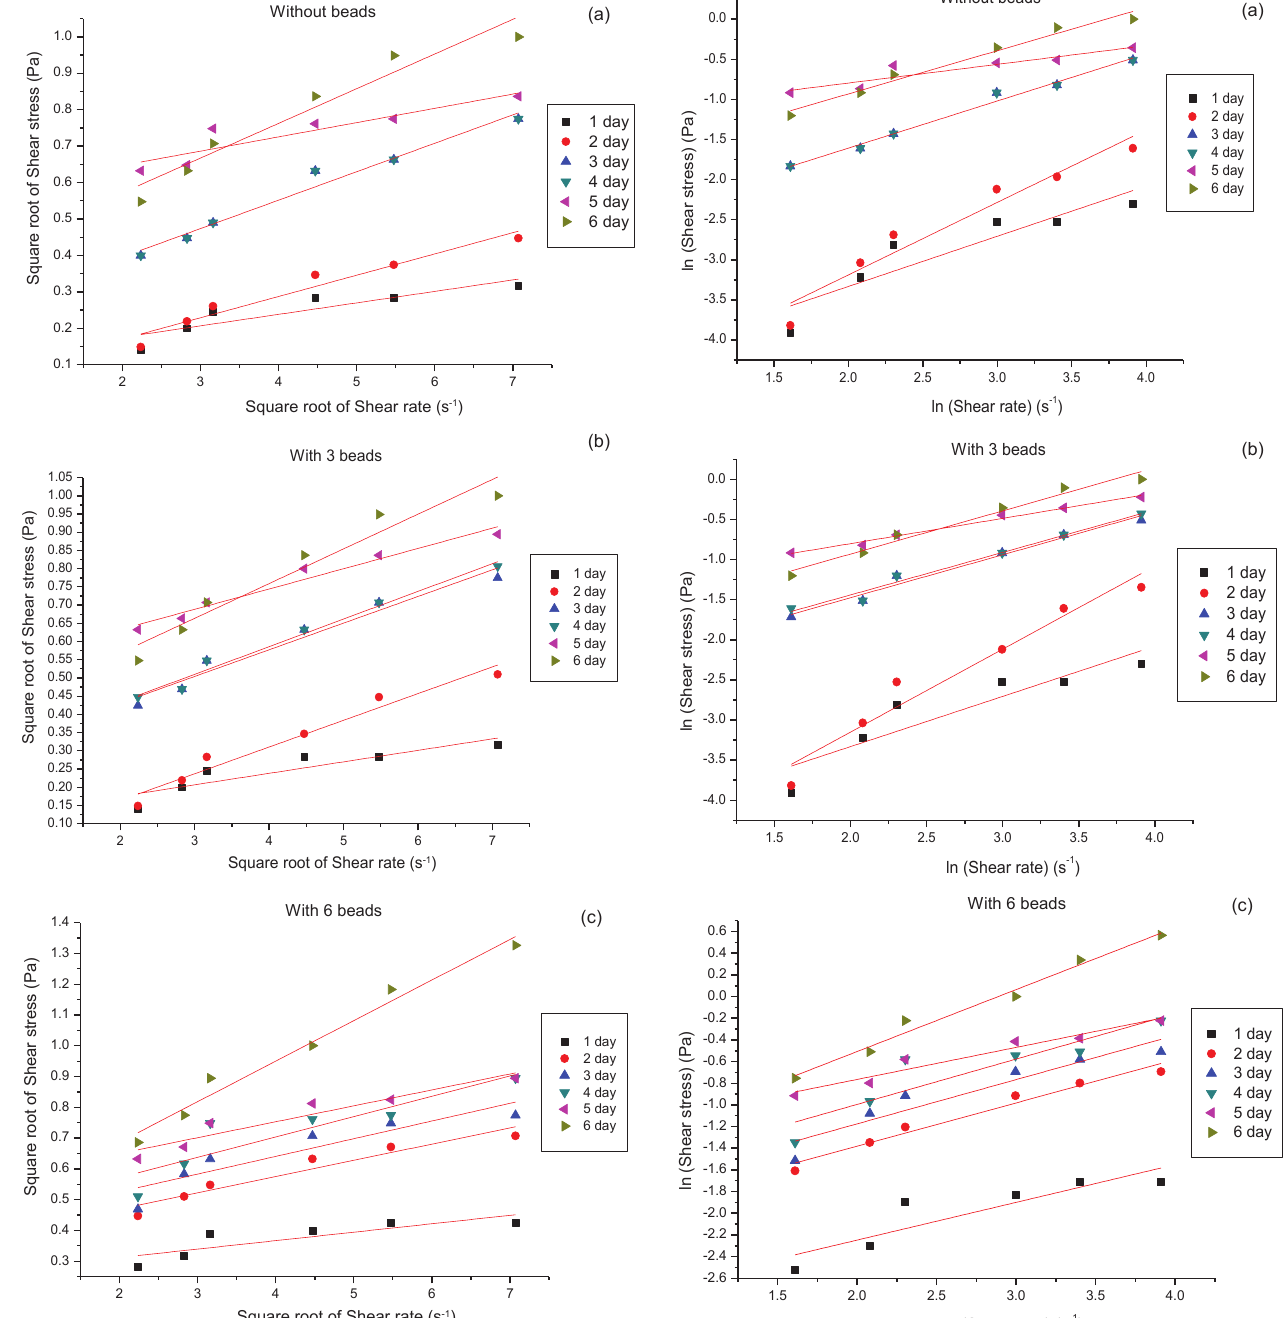
Fig. 5 – Rheological data as predicted by the Power law model for cells grown without beads (a), with 3 beads (b), and 6 beads